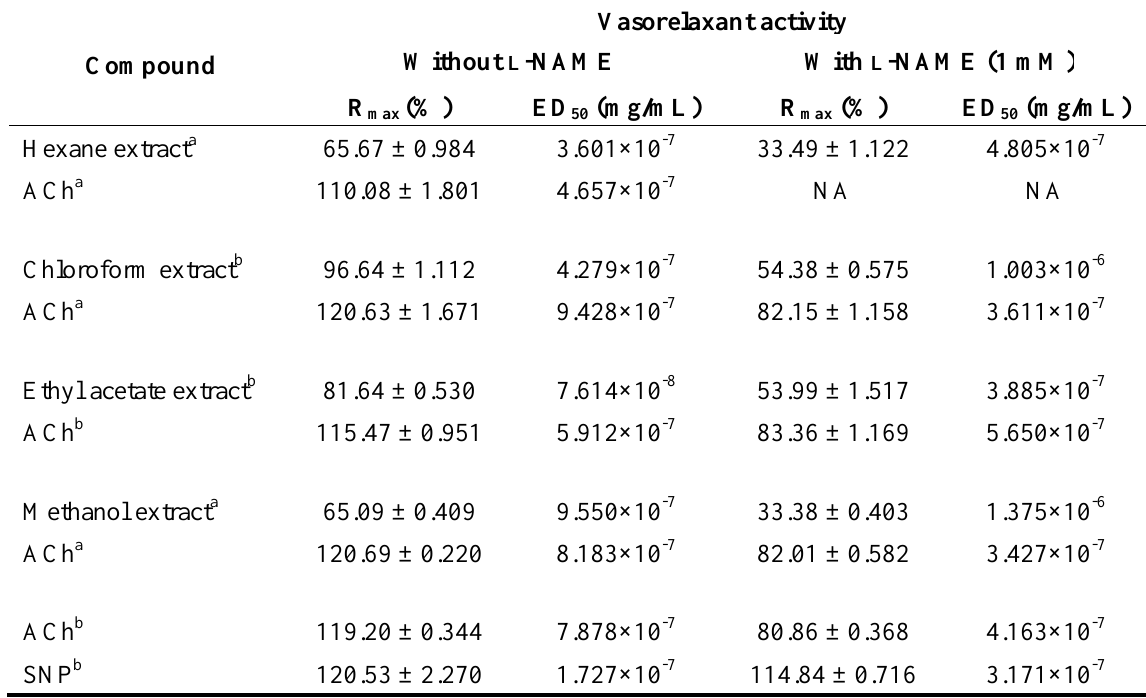
Table 2. Vasorelaxant activity of Spilanthes acmella Murr. extracts on rat thoracic aorta.